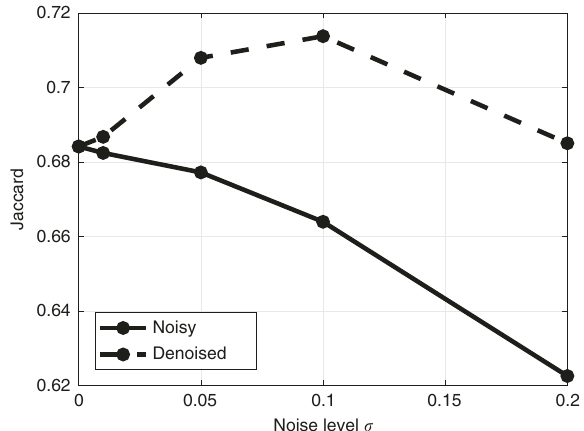
Fig. 8 Segmentation quality of the automated membrane segmentation in the CREMI data set using ilastik. As the noise level in the data increases, the segmentation quality is signi fi cantly in fl uenced whereas denoising pre- processing stabilizes (and even improves) the segmentation